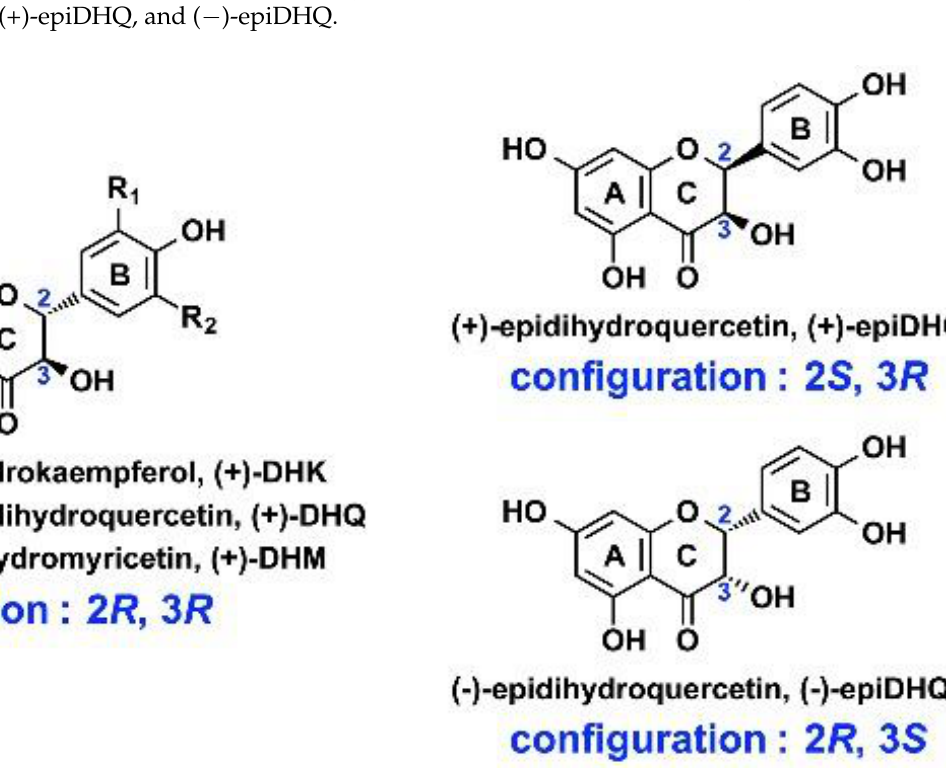
Figure 1. Structures of the five tested dihydroflavonols.